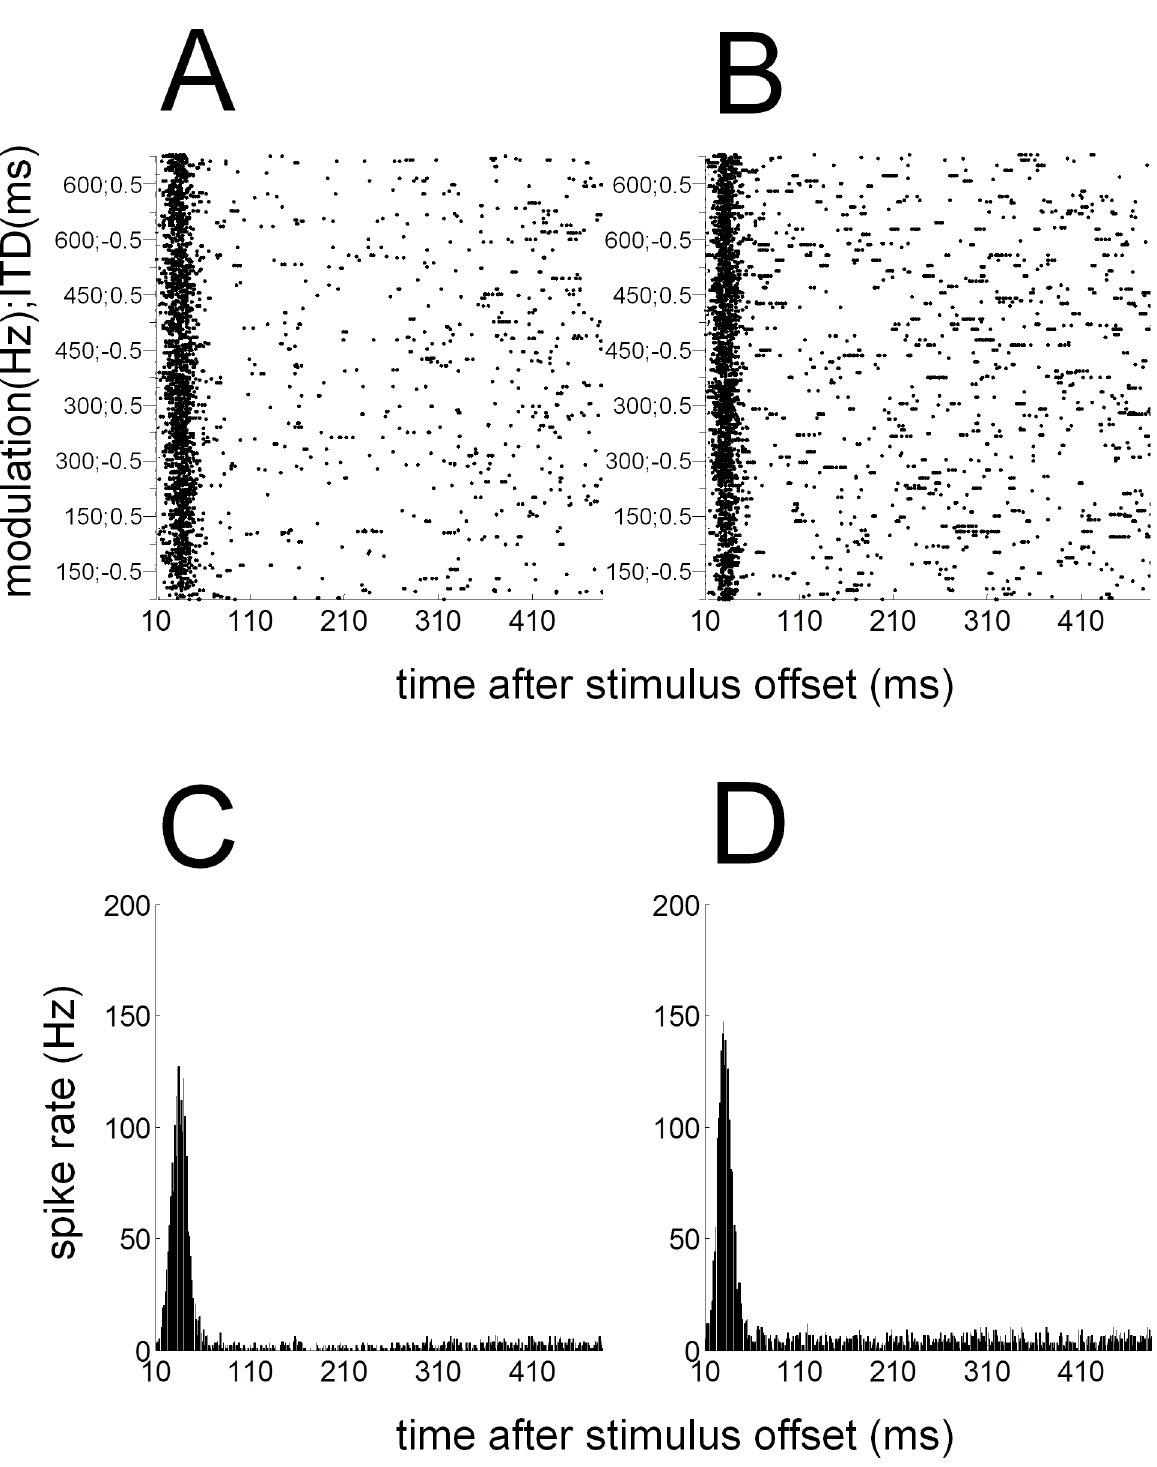
Figure 10. Average ITD sensitivity index for each modulation frequency in normal-hearing animals. Mean ITD sensitivity index ( 6 SD) plotted against modulation frequency for (A) onset and (B) offset responses to SAM (black bars) and HWR tones (grey bars).